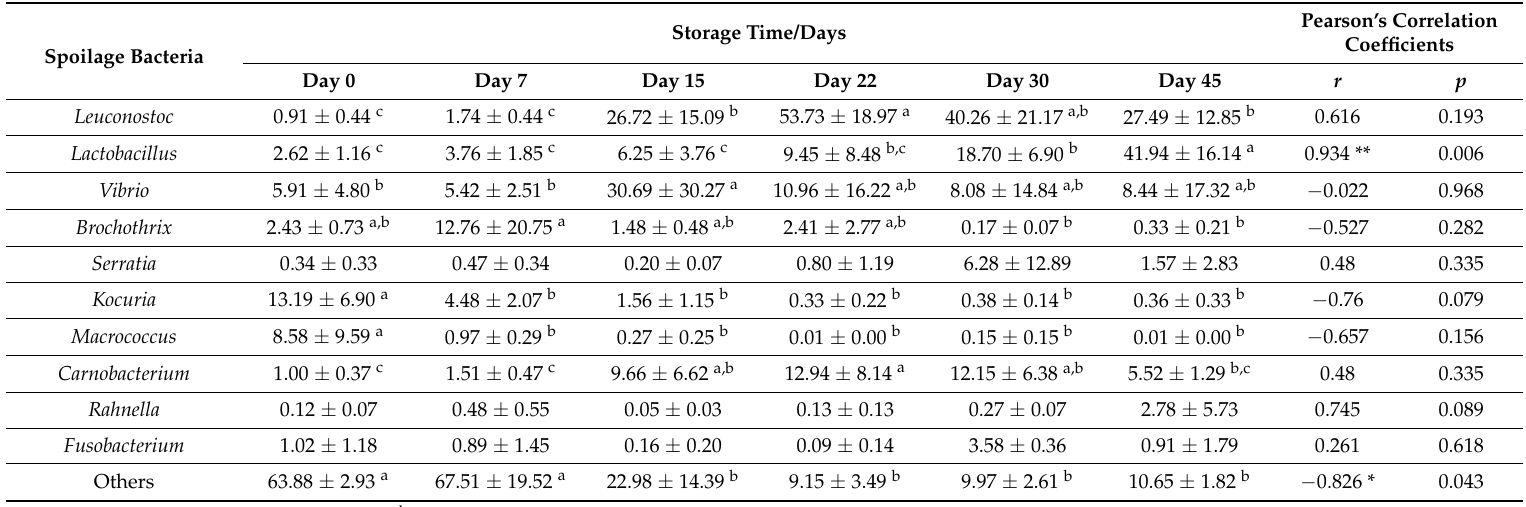
Figures in the table are means and standard error. a,b,c Means within a row refer to the significant difference at p < 0.05 according to Tukey’s multiple range test. Means in the same row with no superscript letters after them or with a common superscript letter following them are not significantly different ( p < 0.05). * Significant at the 0.05 level; ** Significant at the 0.01 level.